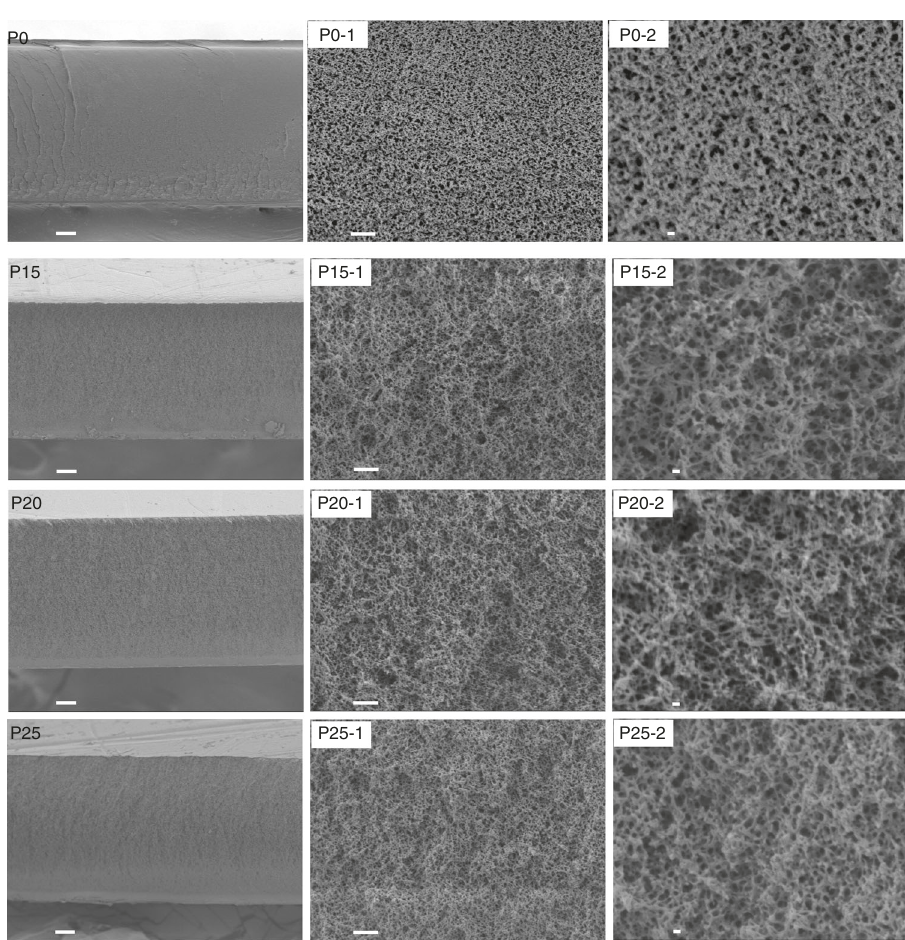
Fig. 2 Cross-section morphologies of the prepared membranes. In PX, X represents the sulfonated poly(ether ether ketone) (SPEEK) content in the polymer (for instance, the SPEEK content in the polymer P20 is 20 wt%). PX-1 and PX-2 are the different magni fi cations of PX. The scale bars for PX, PX-1, and PX-2 are 10 μ m, 1 μ m, and 100 nm,